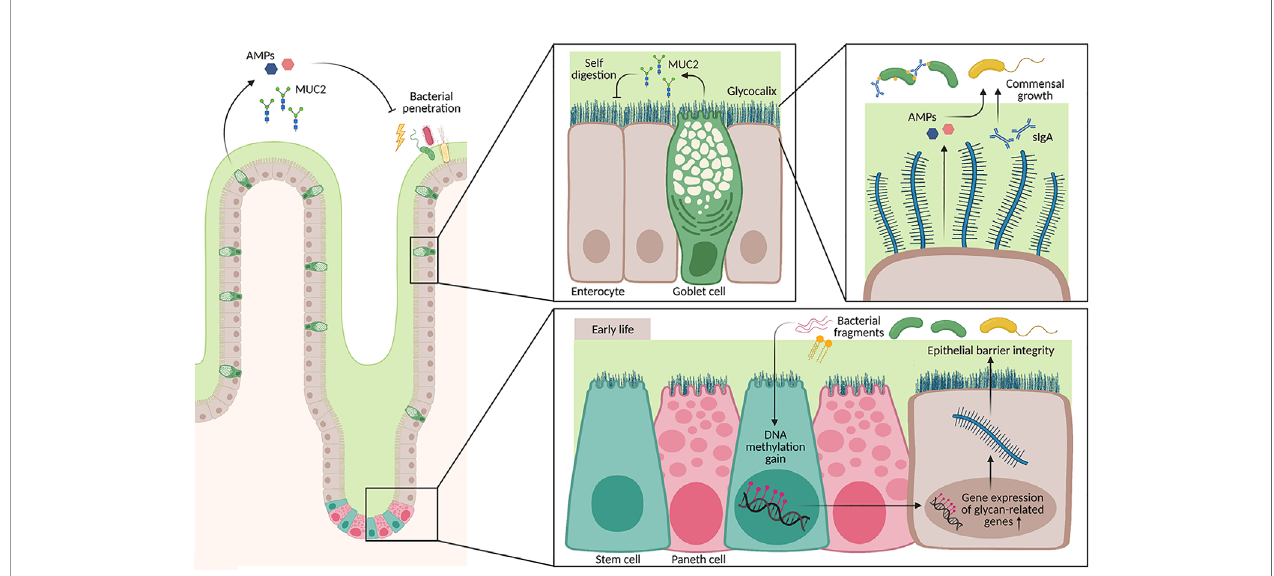
FIGURE 2 | Architecture of the mucus layer in the small intestine. The small intestine has a loose mucus layer (illustrated in green), which keeps commensals at distance. In addition, the epithelium is covered by a glycocalyx, a dense layer composed of secreted mucus proteins (MUC2) that is attached to epithelial cells via the transmembrane part. These layers do not only protect from bacterial penetration, but also from self-digestion of host intestinal tissue. Secretion of AMPs by Paneth cells and other epithelial cells as well as sIgA by plasma cells regulate the growth of different commensal bacterial strains. Furthermore, signals from the neonatal microbiota shape the DNA methylome in intestinal stem cells from birth until weaning. Genes associated with cell glycosylation are particularly affected by a DNA methylation gain, which also correlates with an increase in gene expression. Hence, barrier integrity during early life is additionally ensured through epigenetic remodeling triggered by the